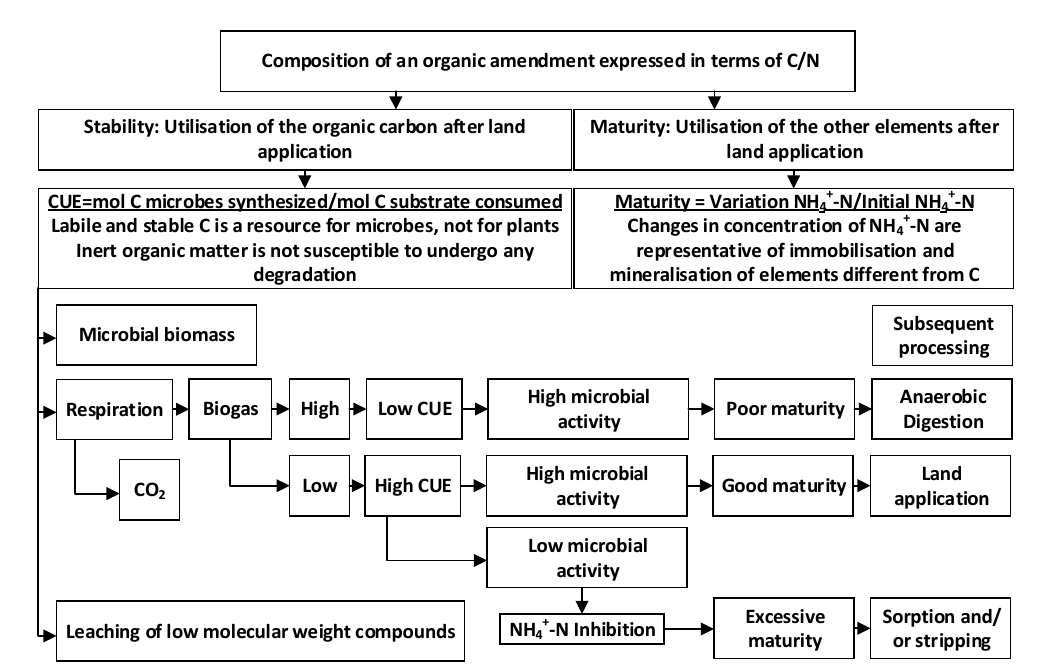
Figure 2. Evaluation of the quality of an organic amendment in terms of stability and maturity [42,49–53].